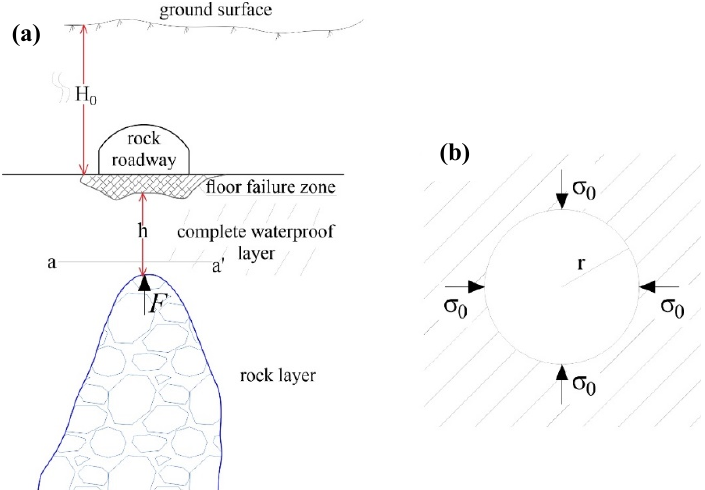
Figure 3. Water bursting mode schematic diagram of collapse column: ( a ) profile of roadway and KCC; ( b ) force diagram of a–a’ section.